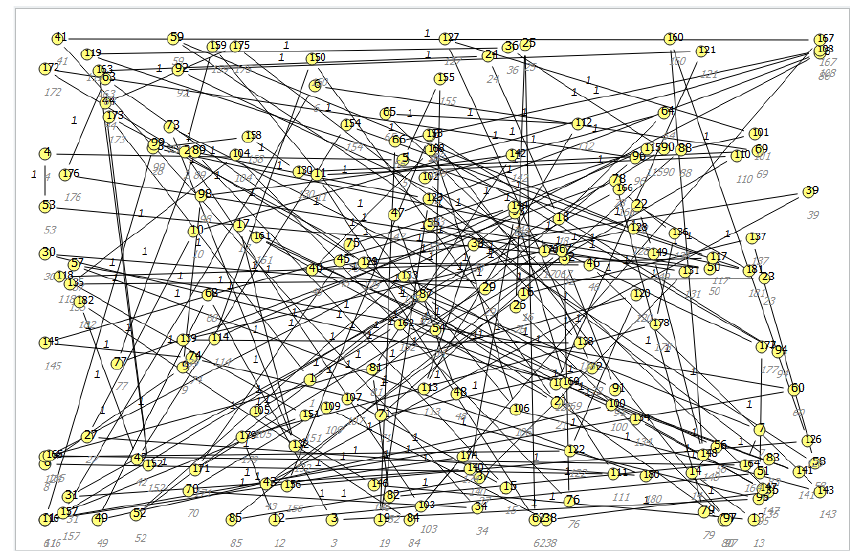
Sensors 2023 , 23 , x FOR PEER REVIEW Figure 18. Search for rule-based dependency in an expert system. Figure 18. Search for rule-based dependency in an expert system.